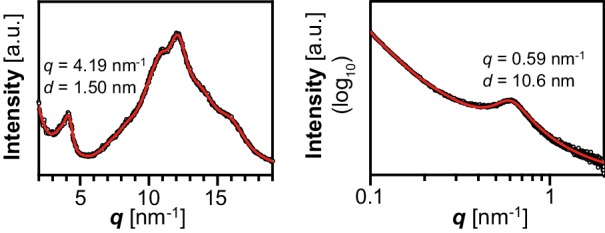
X-ray scattering wild-type Arabidopsis starch.Wide-angle (left) and small-angle (right) X-ray scattering intensity profiles of purified WT Arabidopsis starch (Col-0 ecotype). q, scattering vector; d, lamellar periodicity; a.u., arbitrary units.